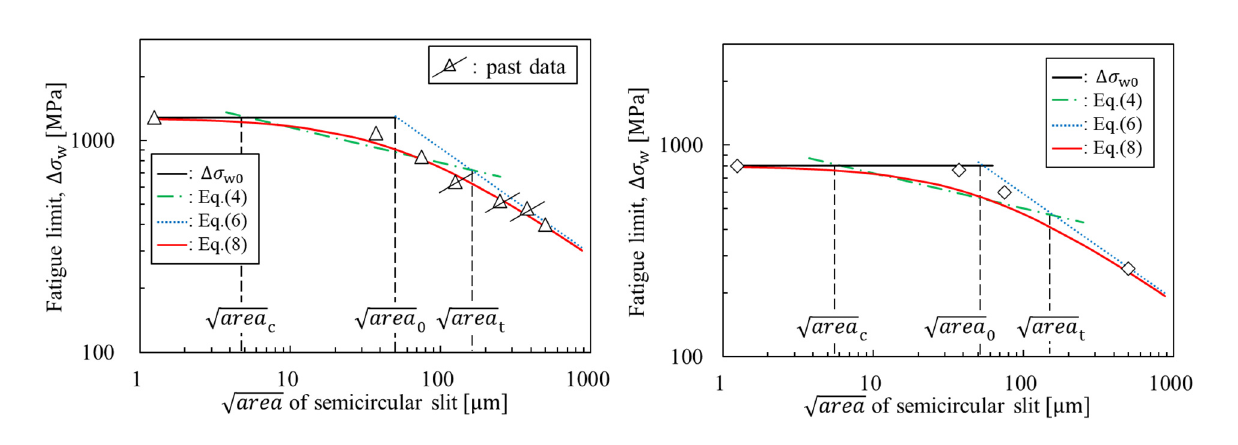
values for various stress ratios. th